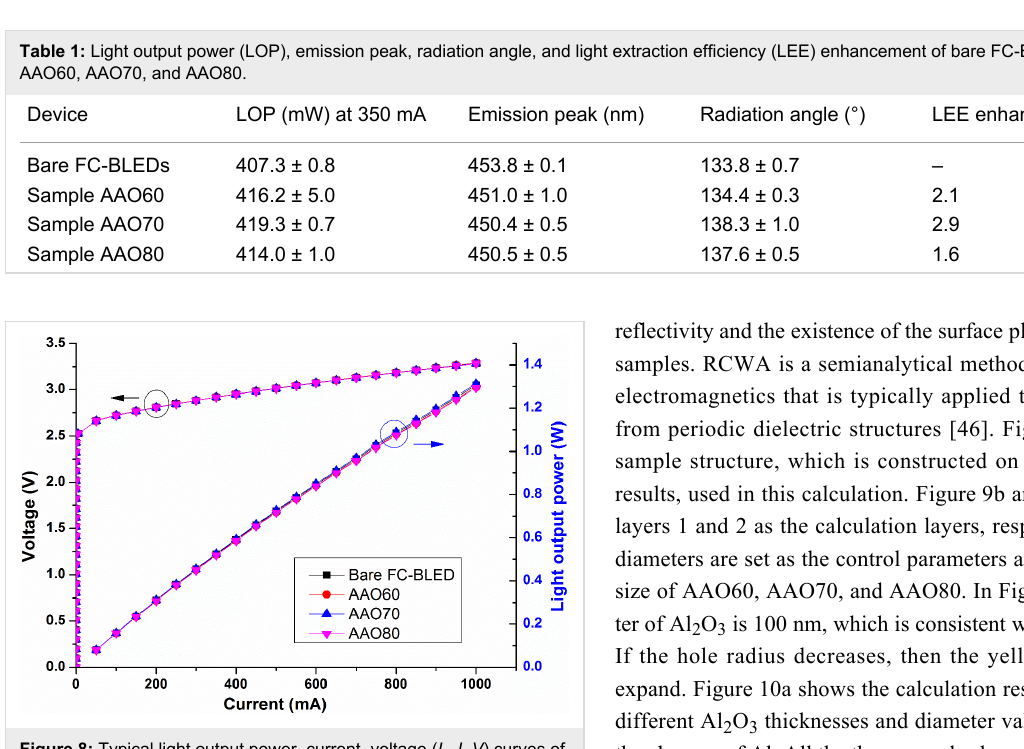
Rigorous coupled-wave